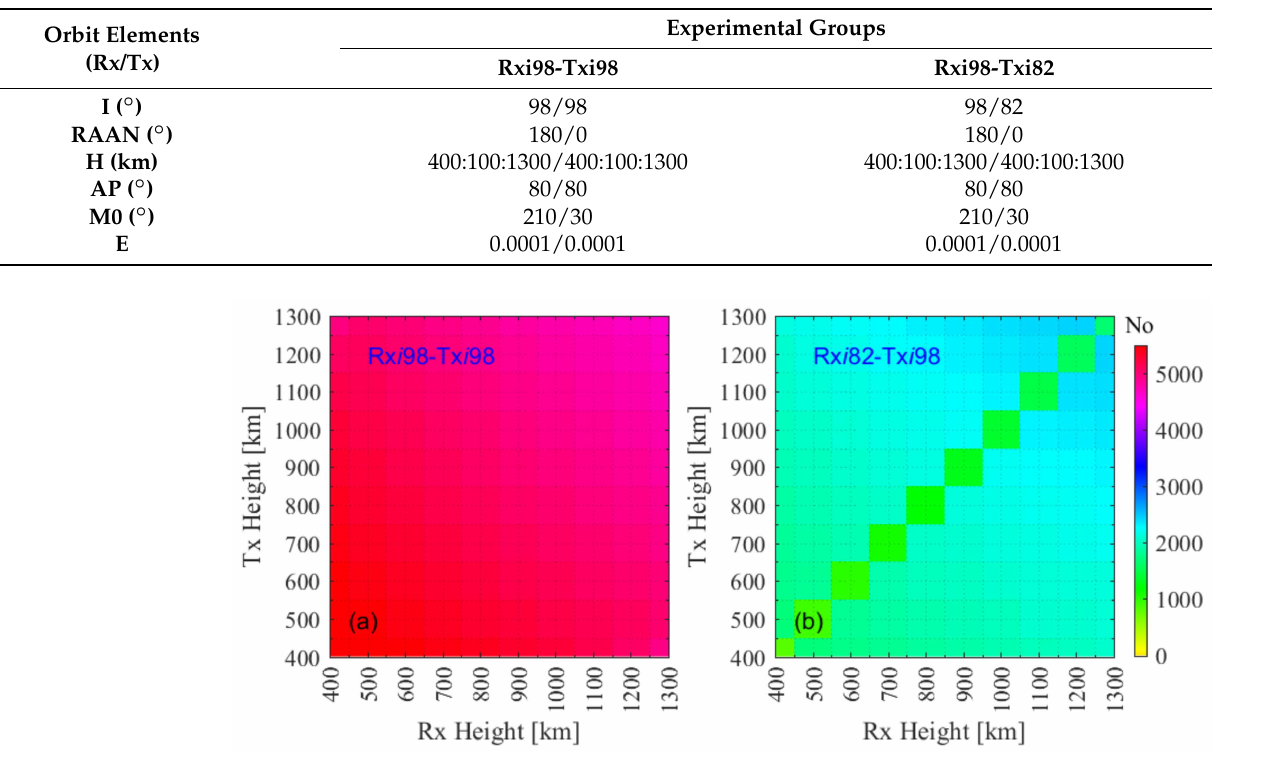
Figure 8. The variation in LEO-LEO occultation event numbers with the Rx and Tx orbital element of height for the Rxi98-Txi98 and Rxi82-Txi98 datasets on event accumulations over 3 months. In the case of Rxi98-Txi82, the impact of height is obvious, especially when the Rx and Tx orbital heights are equal as the number of occultation events drops sharply. To